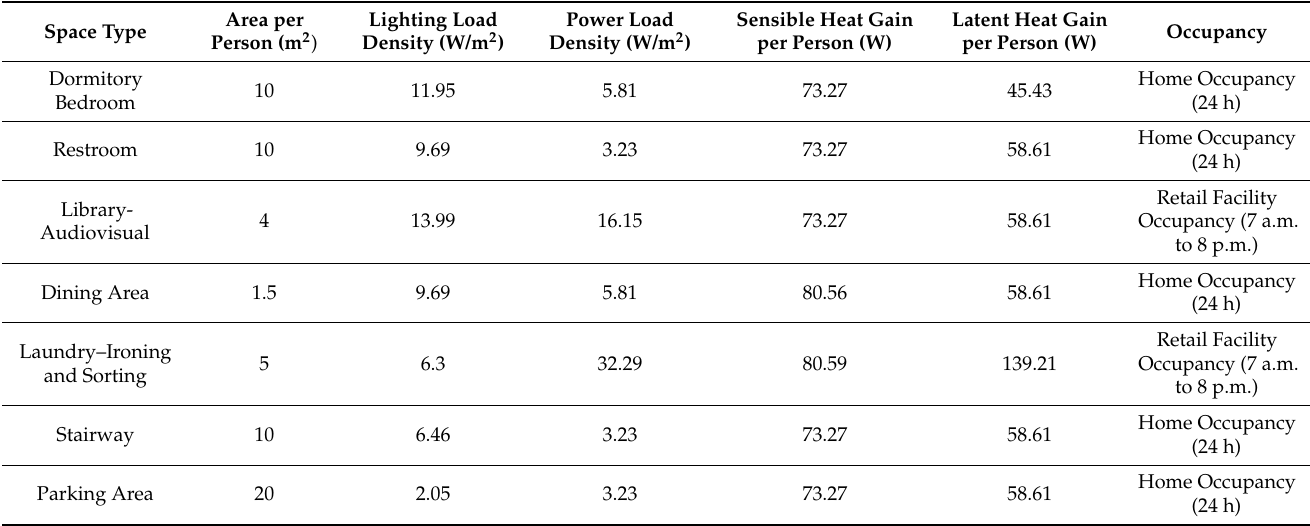
Table 5. Space type description.